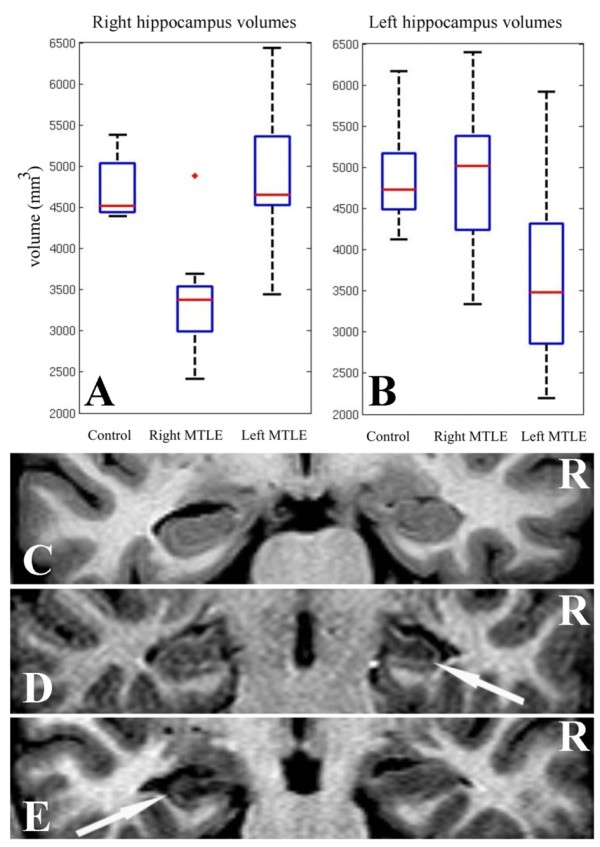
Hippocampal manual volumetric analyses. A) Distribution of the volume of right hippocampus across the groups: control, right MTLE and left MTLE. B) Distribution of the volume of left hippocampus across the groups: control, right MTLE and left MTLE. C) Coronal structural image of normal subject. D) Coronal structural image of patient with right MTLE: Arrow indicates the right hippocampal sclerosis. E) Coronal structural image of patient with left MTLE: Arrow indicates the left hippocampal sclerosis. Abbreviations - R: right hemisphere.